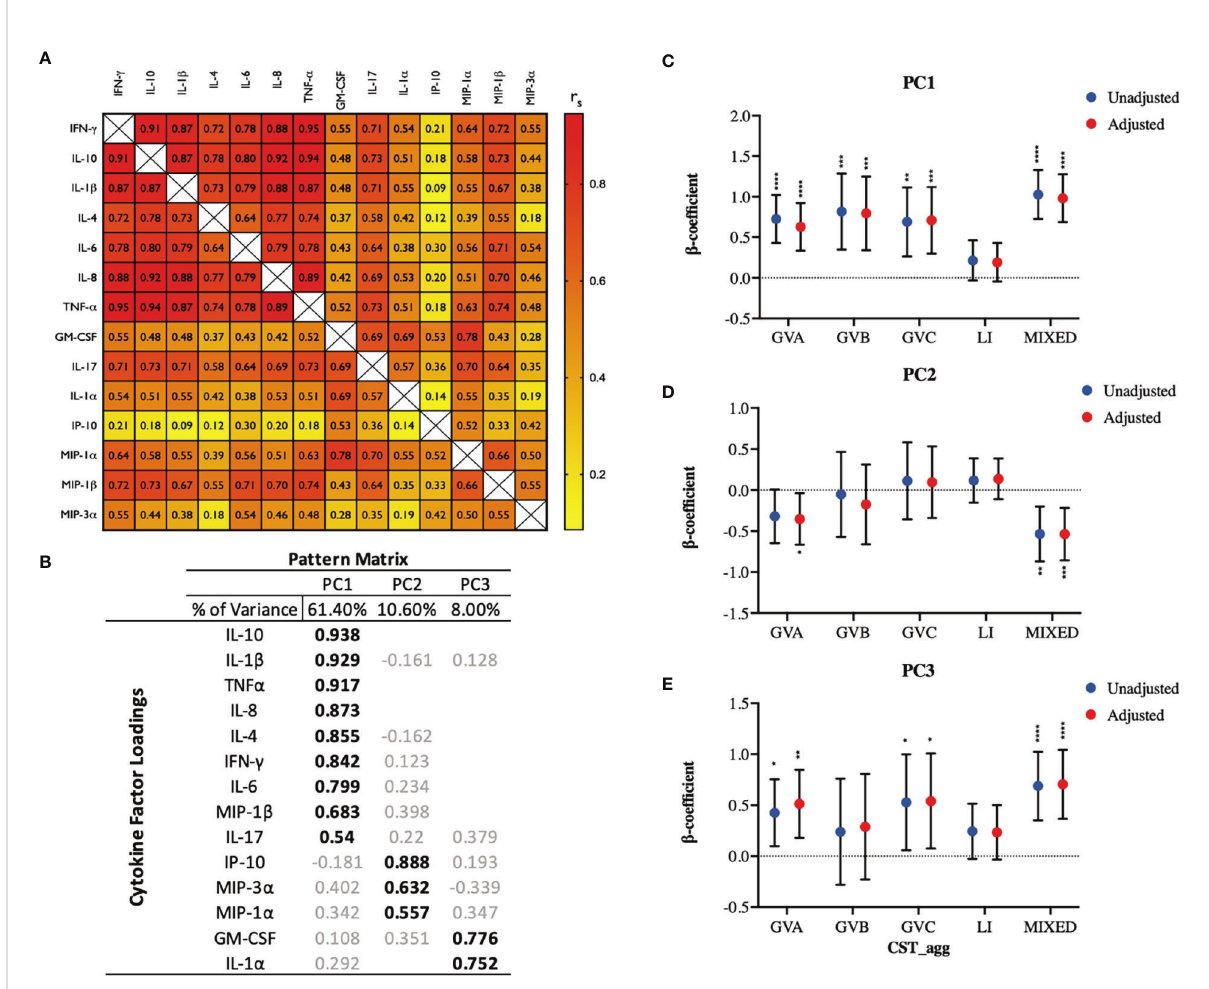
FIGURE 3 Principal component analysis identi fi es three principal components of fourteen measured cervicovaginal cytokines which exhibit divergent associations with cervicovaginal microbiome structures (CST_agg). (A) Spearman correlation matrix showing correlations among all fourteen measured cytokines. (B) PCA pattern matrix (with oblique rotation) showing percent of the variance accounted for by each principal component (PC) and the cytokine loading on each PC. Linear mixed models examining microbial grouping associations with (C) PC1, (D) PC2, and (E) PC3 scores. The b -coef fi cients represent the mean change in speci fi c PC scores associated with a speci fi c microbiome type (CST_agg) compared to Lactobacillus (non-iners) dominant microbial communities. Blue symbols represent unadjusted models only utilizing microbial groupings as predictors. Red symbols represent models following multivariable adjustment for hormonal contraceptive type, concomitant vulvovaginal candidiasis, age, HSV -2 seropositivity at baseline, use of BV antibiotics, use of other antibiotics, and use of antifungals prior to sample collection. The error bars represent the 95% con fi dence intervals associated with the estimates from the linear mixed models. *P ≤ 0.05, **P ≤ 0.01, ***P ≤ 0.001, ****P ≤